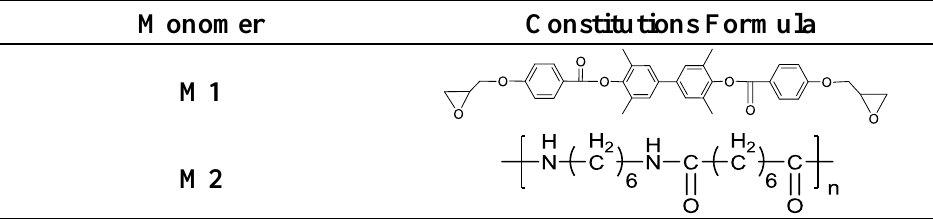
Figure 1. Torque vs. time for blends with different content of M1 performed at 260 °C and 60 min −1